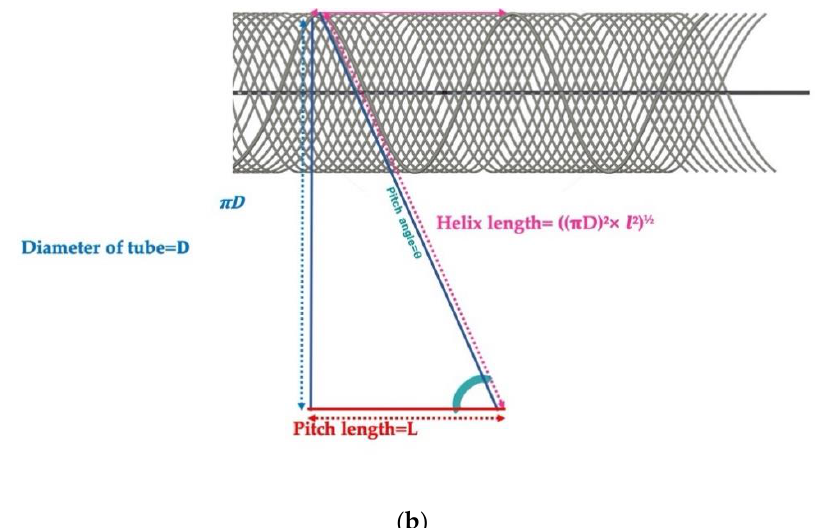
Figure 1. ( a ) A drawing to help understand the definition of Poisson’s ratio. ( b ) The lap angle, lap yarn pitch, and the circumferential length of the braided cross-section, causing a negative Poisson’s ratio in tubular braiding.